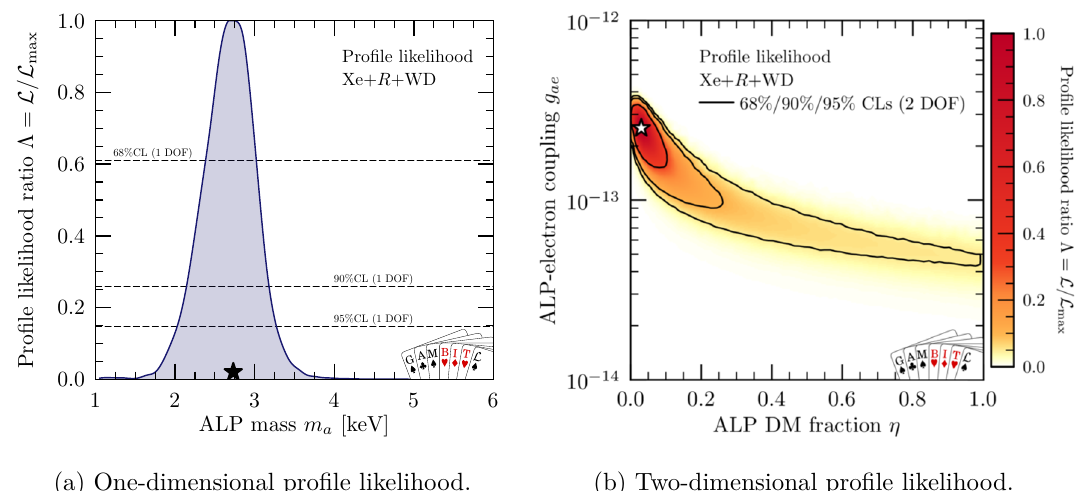
Figure 4. The profile likelihoods with Xe + R + WD data for (a) the ALP DM mass and (b) the ALP DM fraction and ALP-electron coupling. Stars indicate the best-fit